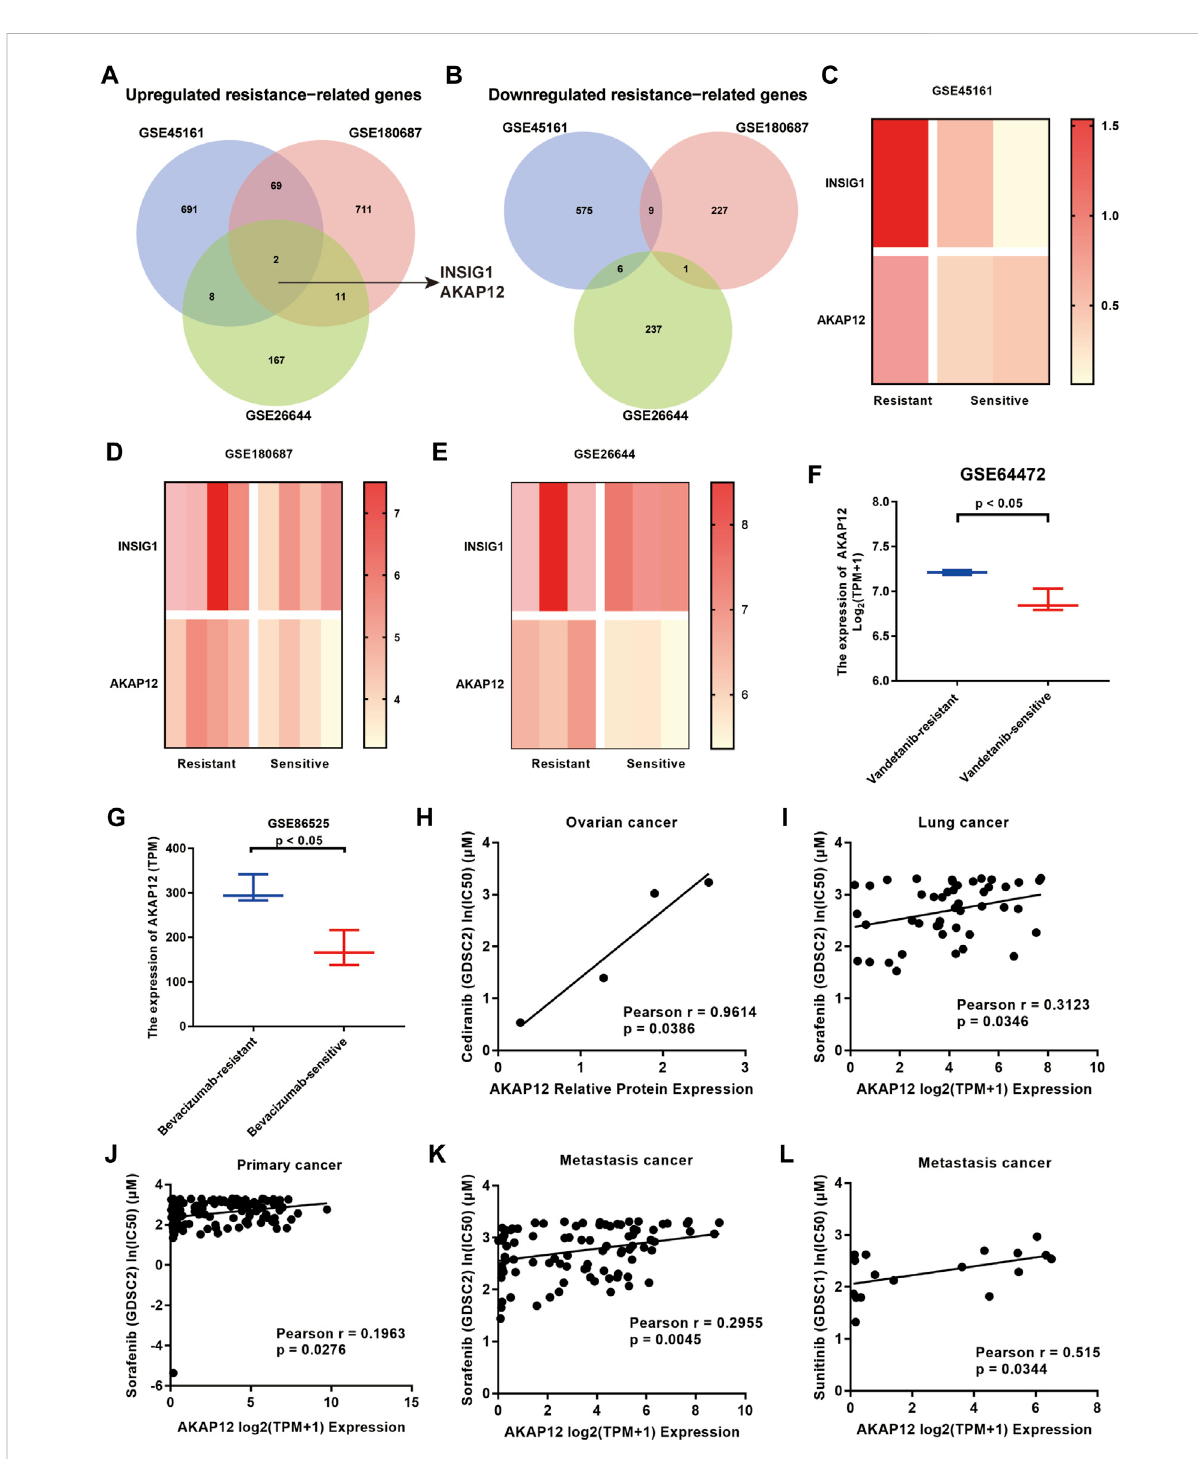
FIGURE 1 Identi fi cation of 2 overlapping differentially expressed genes (DEGs) from 3 GEO datasets (GSE45161 of glioma, GSE180687 of OV, and GSE26644 of NSCLC). (A) Two common DEGs, namely, INSIG1 and AKAP12, were identi fi ed to be overexpressed in three datasets. (B) None of the overlapping DEGs was identi fi ed to be underexpressed in the three datasets. (C – E) Heatmaps of two common DEGs in the resistant group and sensitive group. (F) AKAP12 expression was signi fi cantly elevated in vandetanib-resistant NSCLC compared to vandetanib-sensitive NSCLC tissuesbasedonGSE64472. (G) Relativetobevacizumab-sensitivetissues, AKAP12 expression wasincreasedinbevacizumab-resistantcoloncancer tissues in GSE86525. Scatter plots of the association between AKAP12 expression and IC50 values of cediranib in ovarian cancer (H) , IC50 values of sorafenib in lung cancer (I) , primary pan-cancer (J) , and metastasis pan-cancer (K) , as well as IC50 values of sunitinib in metastasis pan-cancer (L)